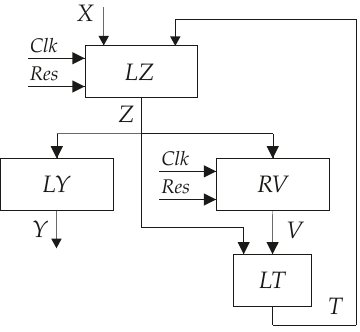
Figure 6. Structural diagram of LUT-based Mealy FSM U 3